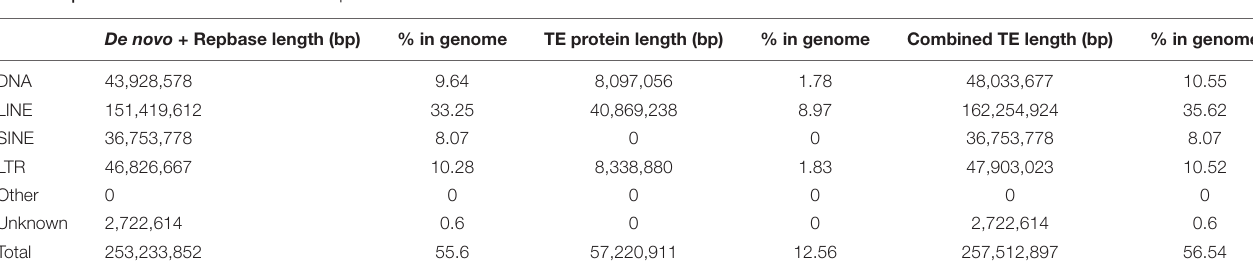
TABLE 3 | Statistics for the classification of repetitive elements.